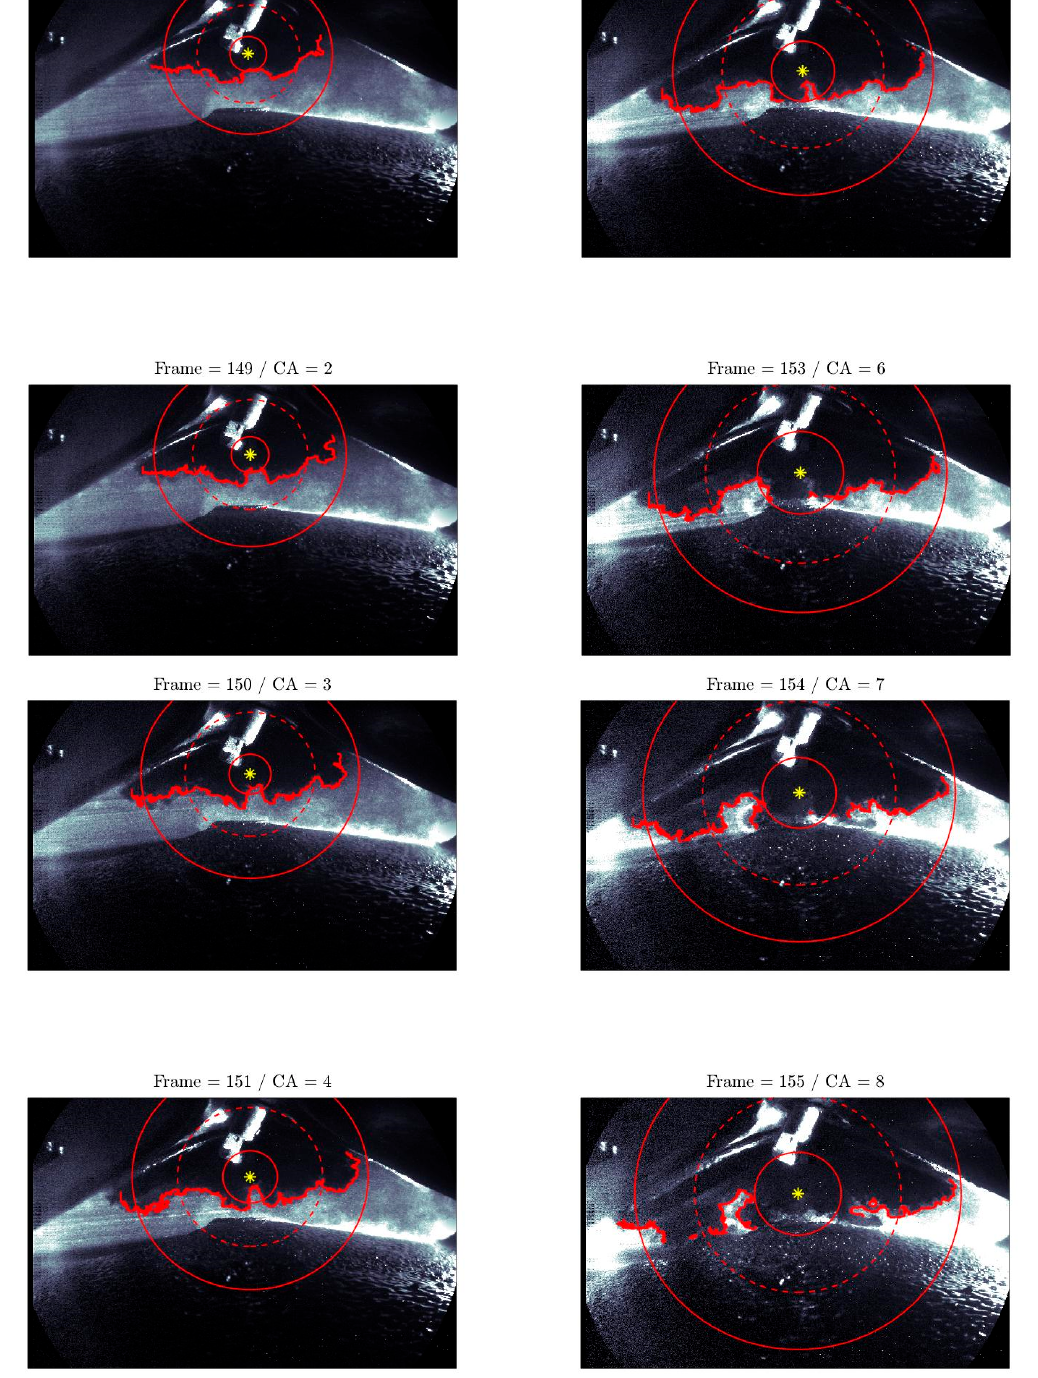
Figure 16. Cycle 60. Background corrected images of turbulent flame from 1 to 8 CAD after TDC firing. Superimposed geometric properties: flame edges, flame center, min, max, and average radii. Engine operation: 1000 RPM, wide open throttle.